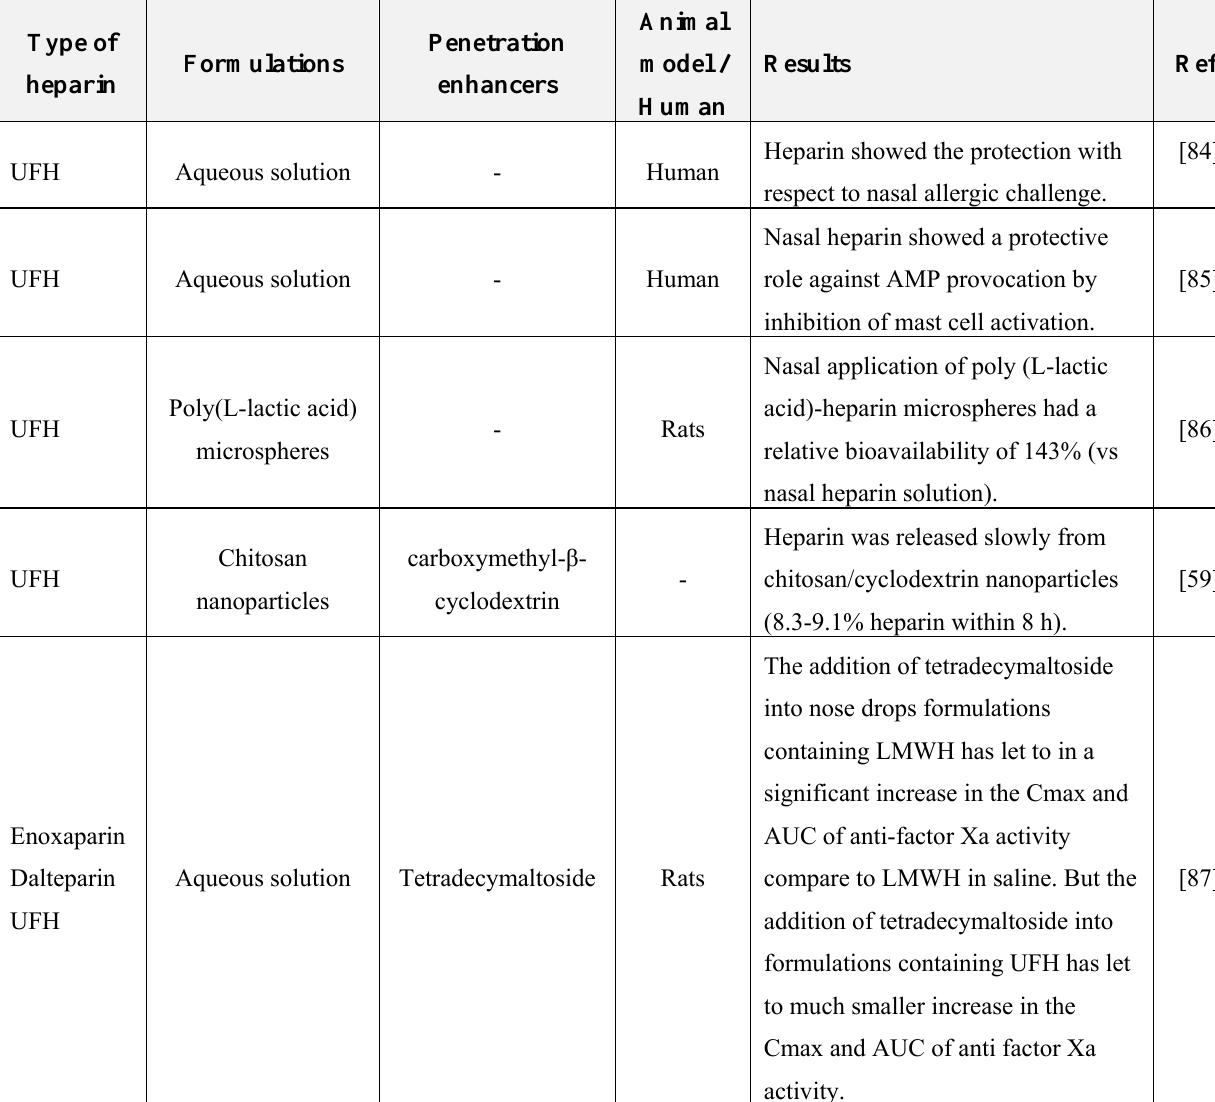
Table 3. Studies on the nasal heparin